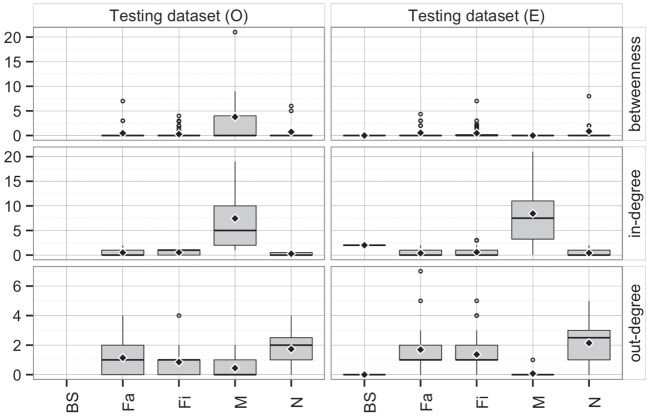
Boxplot of betweenness, in- and out-degrees in the testing dataset for observed (O) and predicted (E) movements by type of site. Boxes indicate the first and third percentile; middle bar represents the median and diamonds represent the mean values.